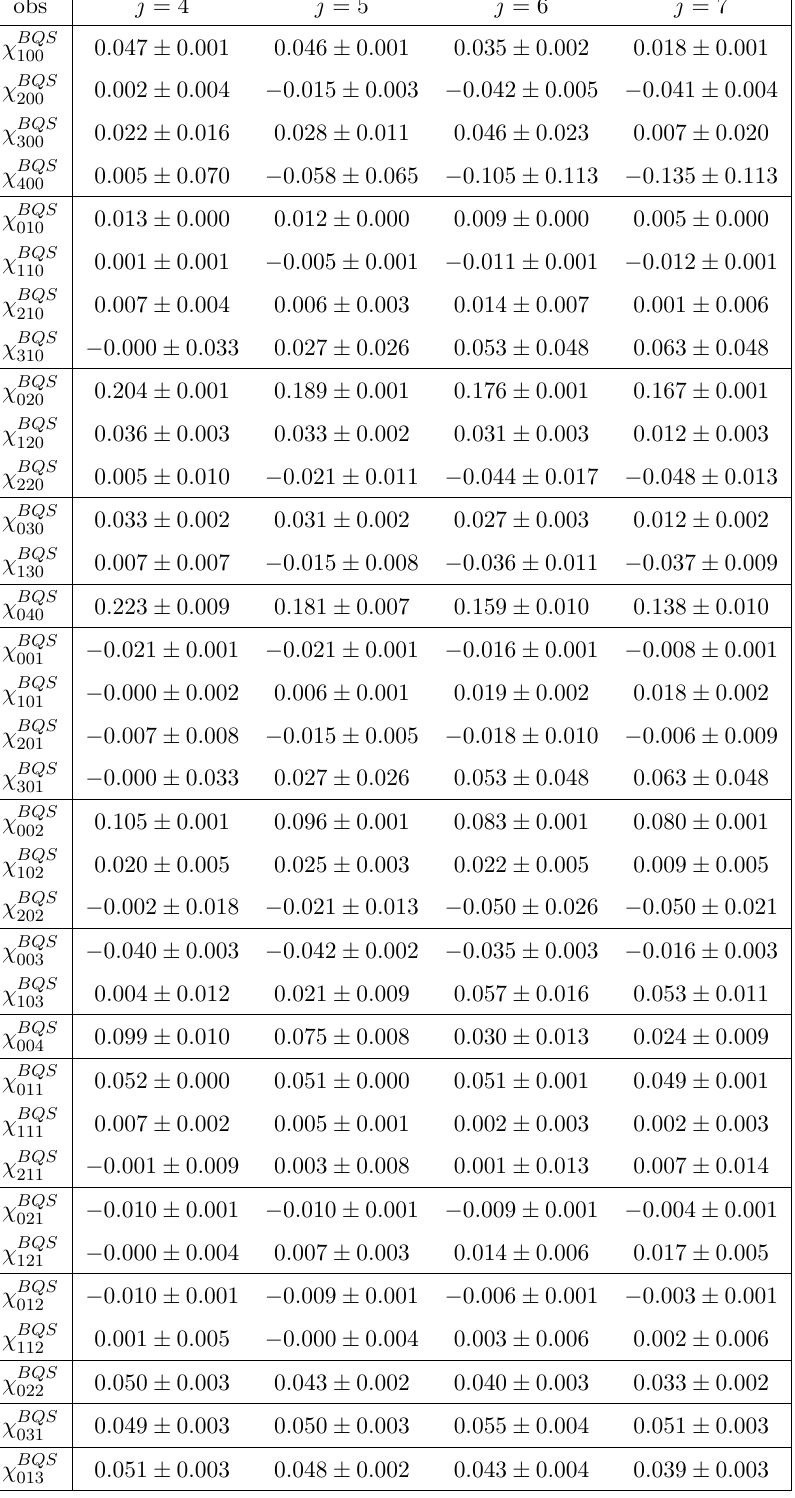
Table 4 . Raw data at T = 140 MeV and (cid:22) ( j )